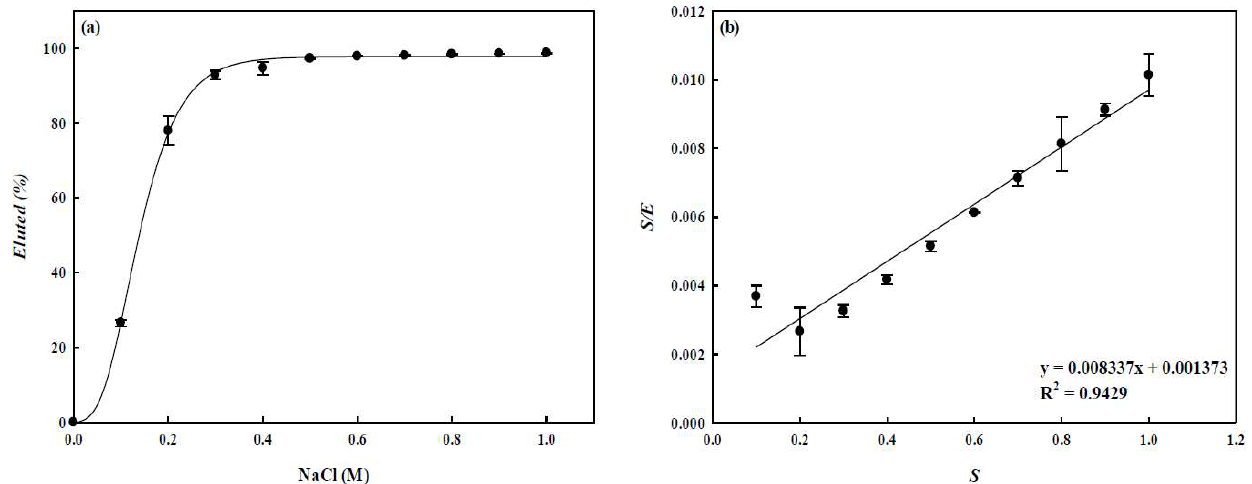
Figure 9. (a) Elution efficiency ( E ) for the adsorbed lysozyme from the P-COOH-CS-RG19 nanofiber membrane by a step- wise elution method (i.e., S: 0–1 M NaCl), ( b ) Linear plot of S/E against E